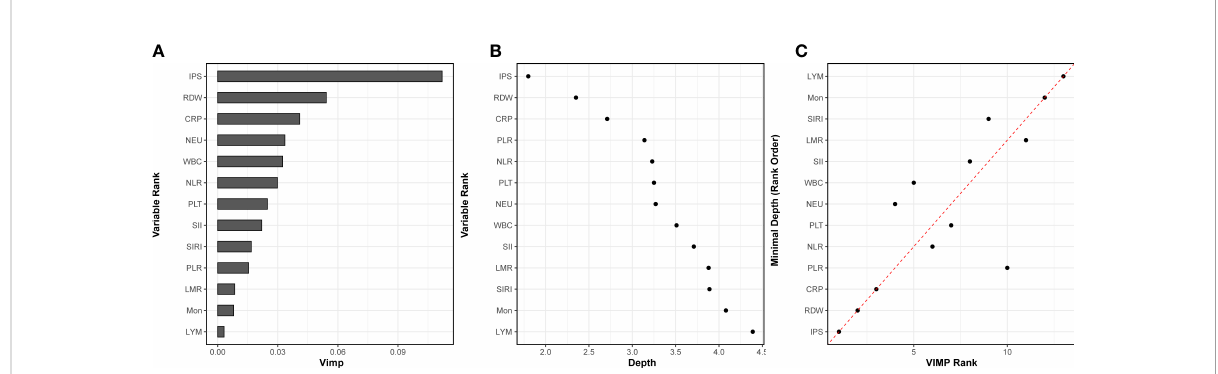
FIGURE 7 Importance from random survival forest analysis for all-cause mortality in acute heart failure patients. (A) variable importance (VIMP) is the difference in validation set prediction error before and after the permutation of variables, the larger values of VIMP indicate the more predictive of the variable. (B) minimal depth (MD) indicates the impact of the variable on the prediction, the lower values of MD indicate that variable has stronger predictive value. (C) Comparison of the VIMP ranking and MD. The farther the points are from the diagonal dash-line, the more the discrepancy between measures. IPS, in fl ammatory prognostic scoring; CRP, C-reactive protein; WBC, white blood cell; NEU, neutrophils; LYM, lymphocyte; Mon, monocyte; RDW, red cell distribution width; PLT, platelet; NLR, neutrophil-to-lymphocyte ratio; PLR, platelet-to-lymphocyte ratio; LMR, lymphocyte-to-monocyte ratio monocyte; SII, systemic immune-in fl ammation index; SIRI, systemic in fl ammatory response